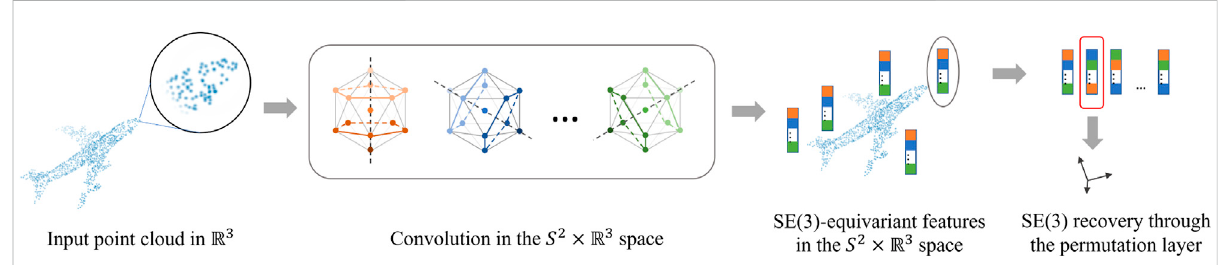
FIGURE 14 Ahigh-levelillustrationofouref fi cientSE(3)-equivariantnetwork.Welifttheconvolutionto S 2 × R 3 ,whichisararechoiceforSE(3)-equivariant feature learning. The different colors represent channels in S 2 .